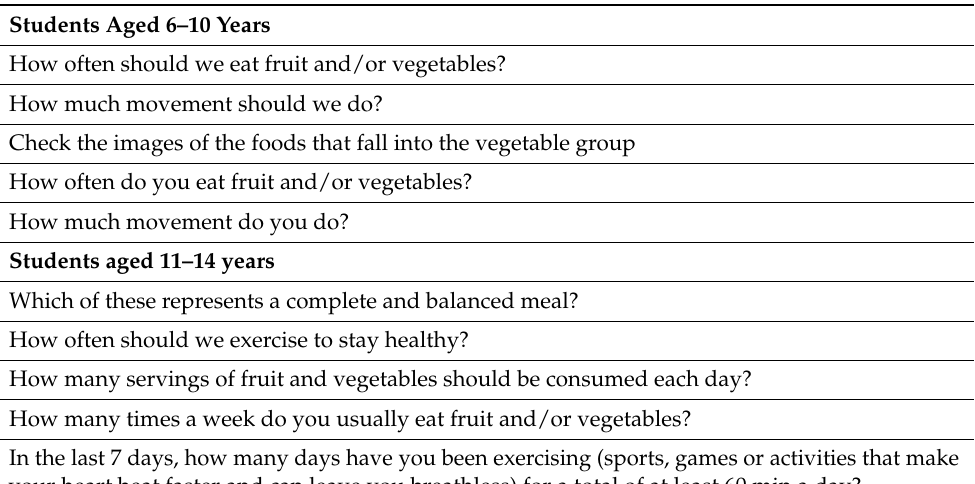
Table 2. Lists of questions used to check students’ knowledge and